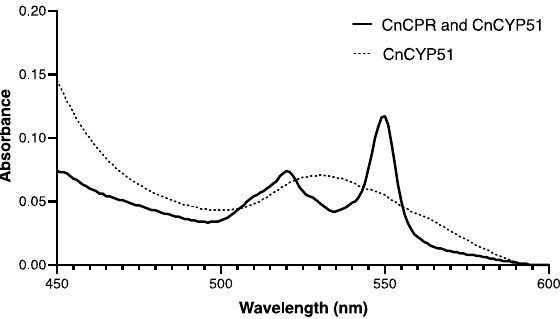
Figure 7. Absorbance spectra of cytochrome c reduction by CnCPR-6×His.